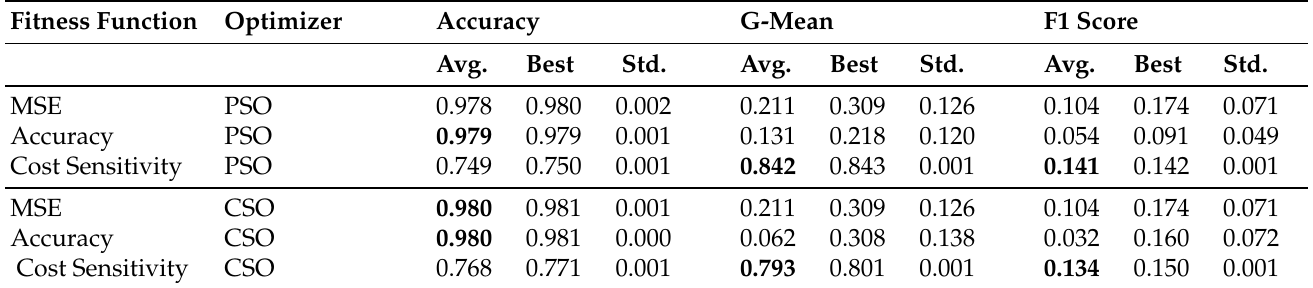
Table 8. The results of the evaluation metrics for all of the fitness functions that were applied to the dataset of Spanish companies per optimization algorithm. The best average result for each metric is marked in boldface.